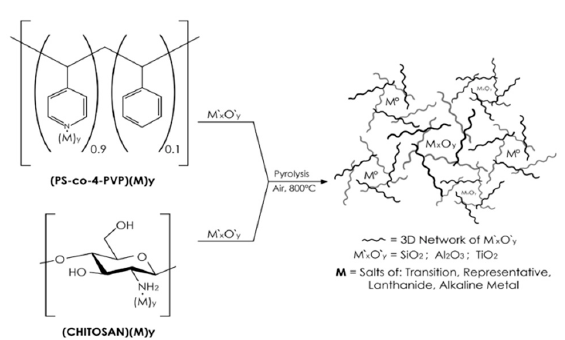
Figure 1. Schematic representation of the preparation method of metallic M ° and metal oxides M x O y nanoparticles inside M’ x O´ y matrices.